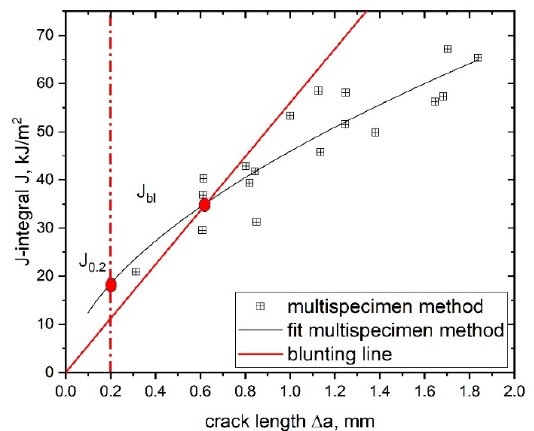
Figure 2. Evaluation of the initiation toughness parameters J 0.2 and J bl from the J–R curve (adapted with permission from [25]).